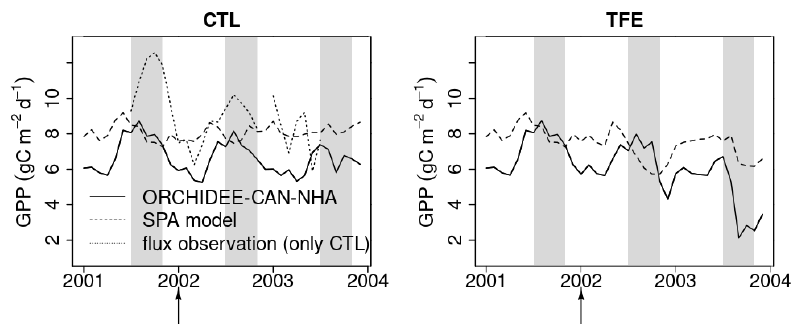
Figure 6. Modeled (ORCHIDEE-CAN-NHA) vs. observed/modeled monthly mean GPP. The control model is compared to flux-tower observations (Carswell et al., 2002). In the case of TFE, as no observation is available, the locally calibrated SPA model is used. Due to GPP, flux observation is unrealistically low at the start of 2001 ( < 5gCm − 2 d − 1 ), we only keep flux data after mid-2001. The shaded gray vertical area indicates the dry season from July to November.